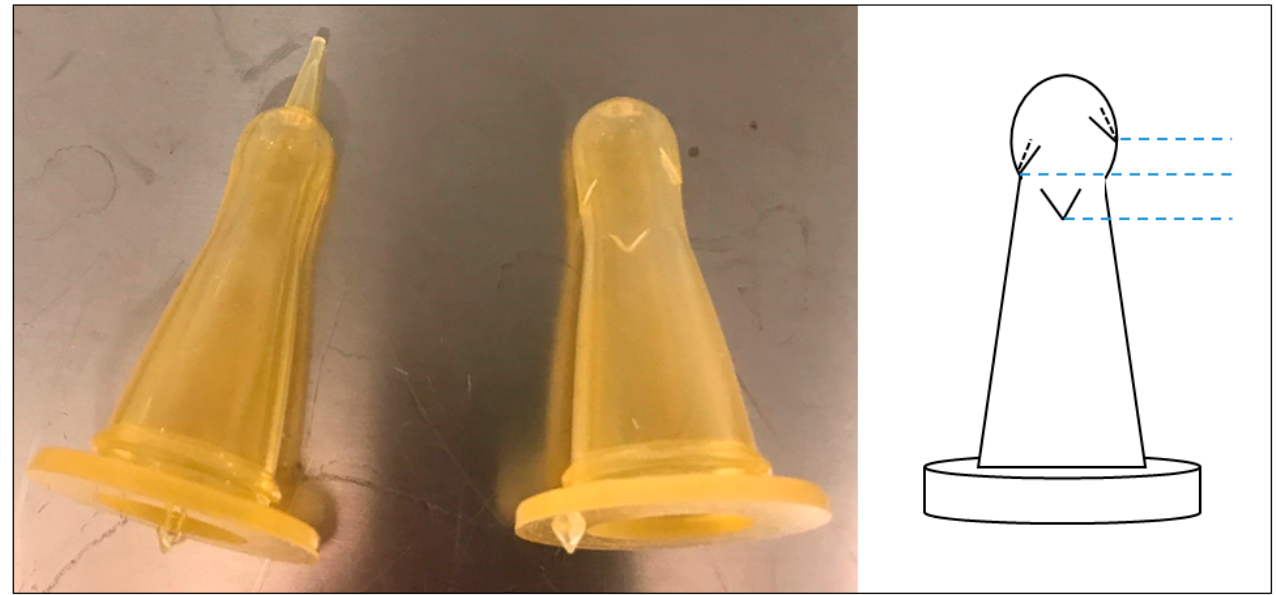
Figure 2. Picture and schematic drawing of modified rubber teat for feeding-bottle used for oral glucose tolerance testing in pigs. Blue dotted lines demonstrate three different levels on the teat at which cuts are made.